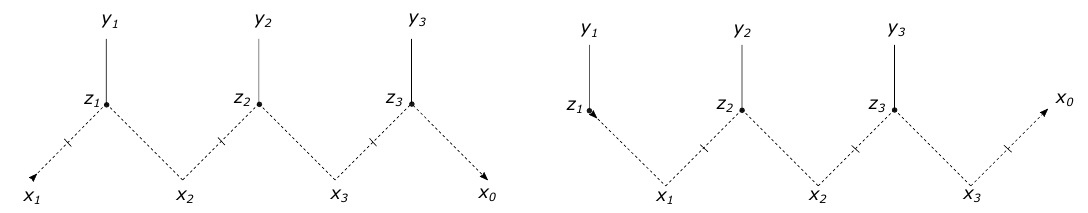
) as in formula (7.6). On the right,